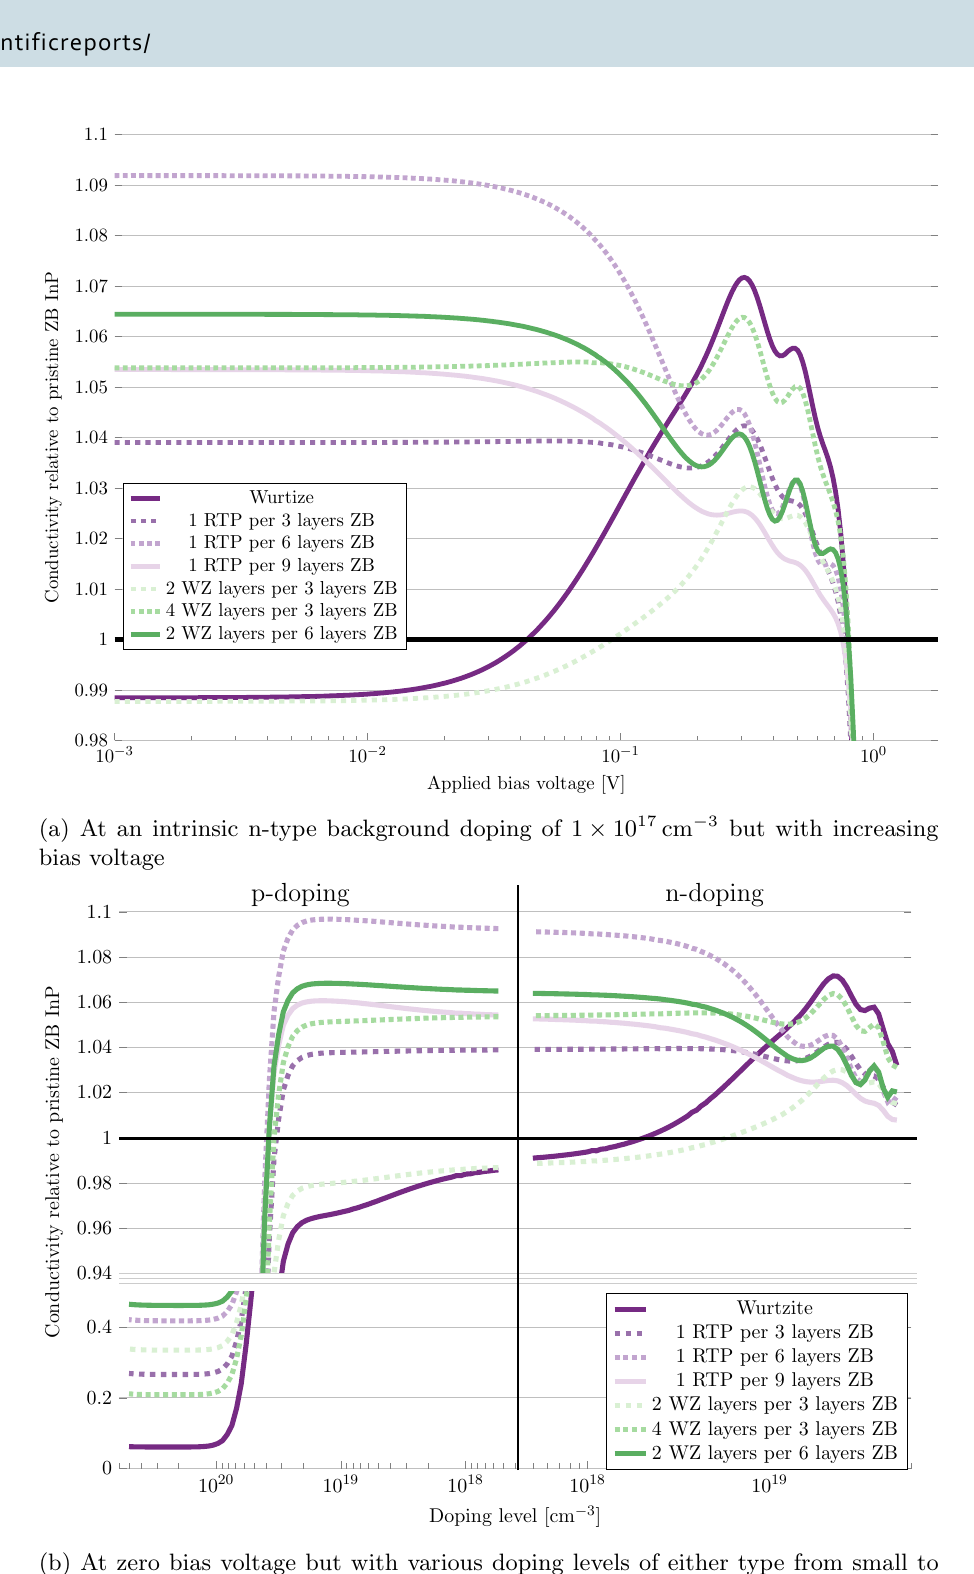
¯ 2 ¯ 1 ]/[10 0] crystallographic